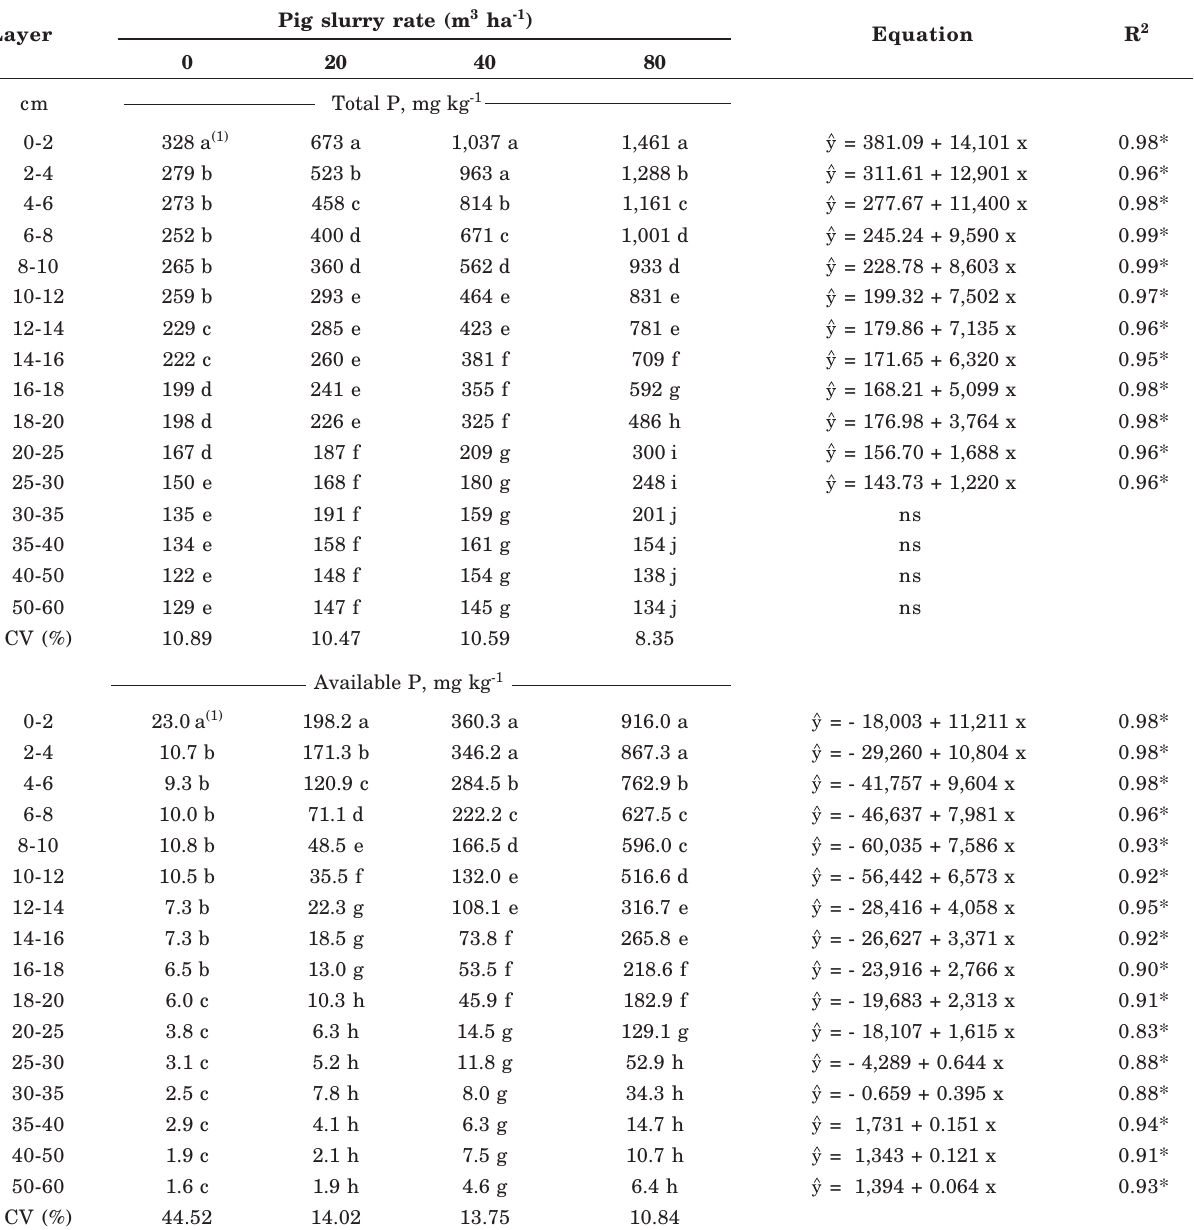
Table 4. Amounts of total and available phosphorus (P) in layers of a Typic Hapludalf after 19 pig slurry